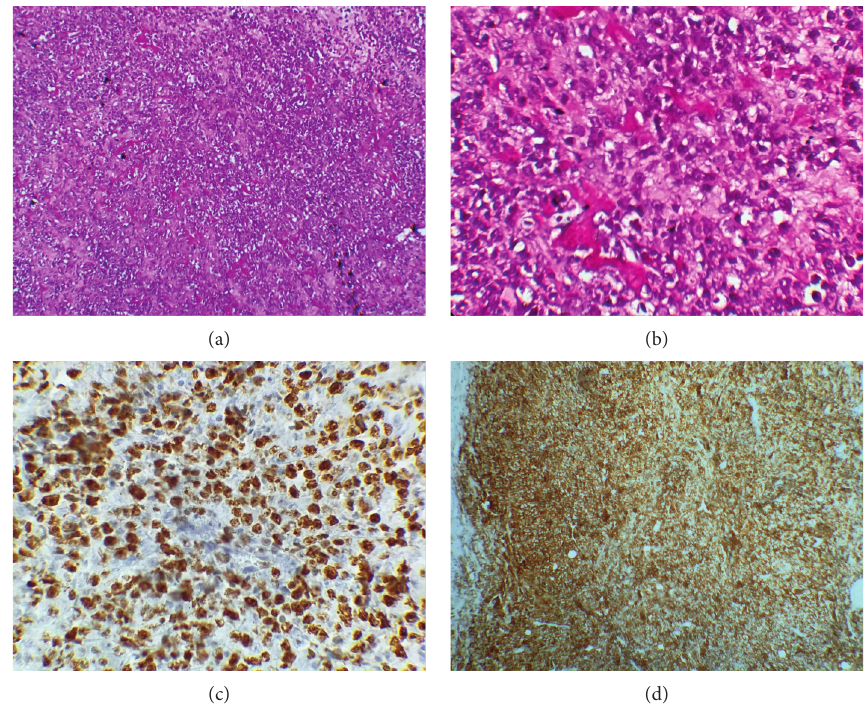
Figure 3: Histopathological examination. (a) Diffuse proliferation of atypical lymphoid cells (HE, GX 40). (b) Large numbers of lym- phocytes ranging in size from medium to large, with oval or round nuclei containing fine chromatin and scanty cytoplasm (HE, GX 200). (c) Immunohistochemical staining was positive for CD20 (a B-cell marker). (d) The Ki-67 index was positive in